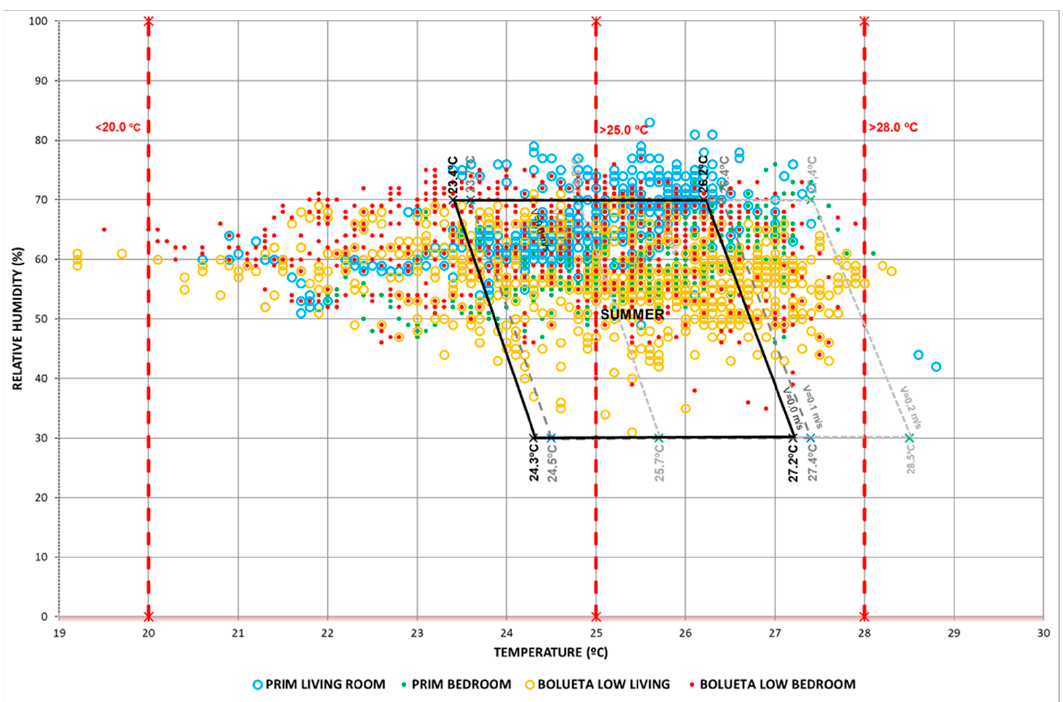
Figure 22. Summer comfort diagram comparison for both Prim and Bolueta Low case studies. Au- gust 2020. Source: authors.